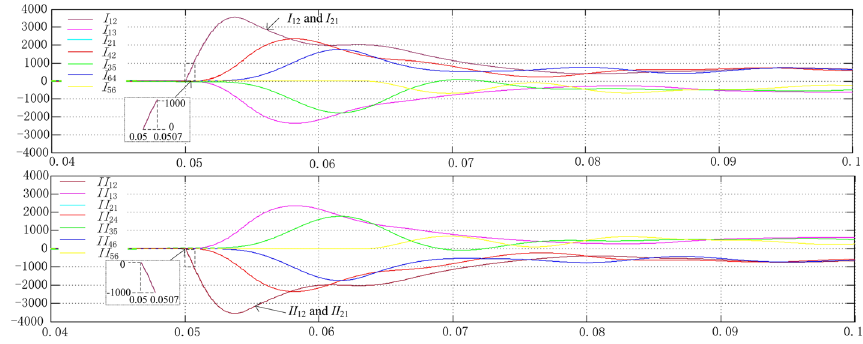
Fig. 12 Pole-to-pole fault condition